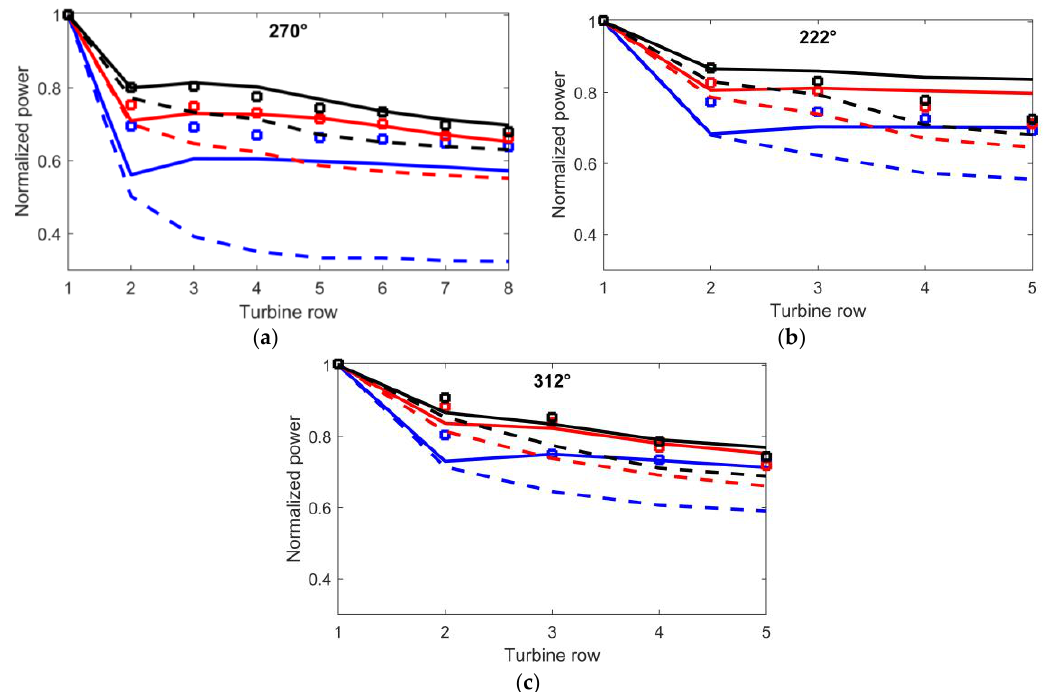
Figure 8. Comparison of the simulated and observed power output centered on three mean wind directions 𝜃 𝑤𝑖𝑛𝑑 = 270° ( a ); 222° ( b ) and 312° ( c ). Symbols, lines, and dashed lines denote the observed, new analytical model, and WAsP data, respectively. Blue, red, and black colors represent ±5°, ±10°, and ±15° wind sectors, respectively.